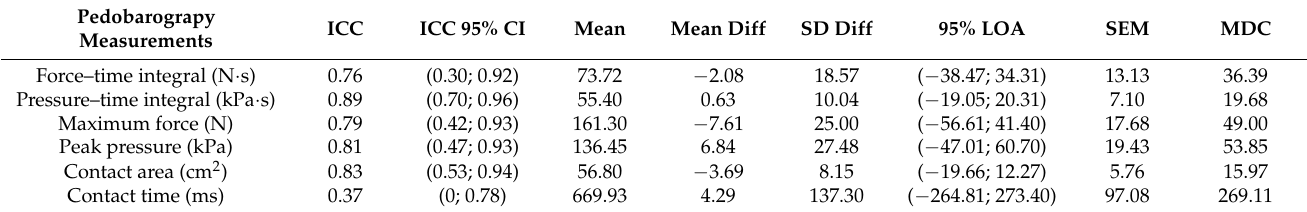
Table 2. Reliability values for pedobarography measurements (whole foot).